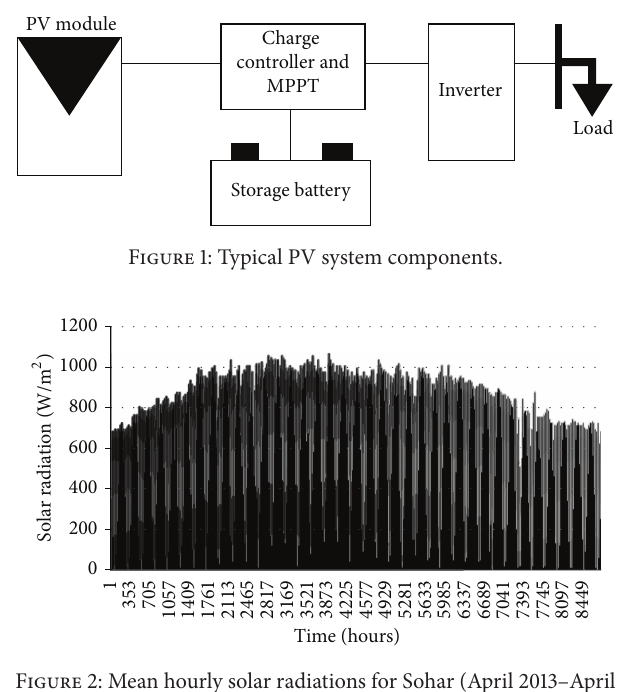
Figure 2: Mean hourly solar radiations for Sohar (April 2013–April 2014).